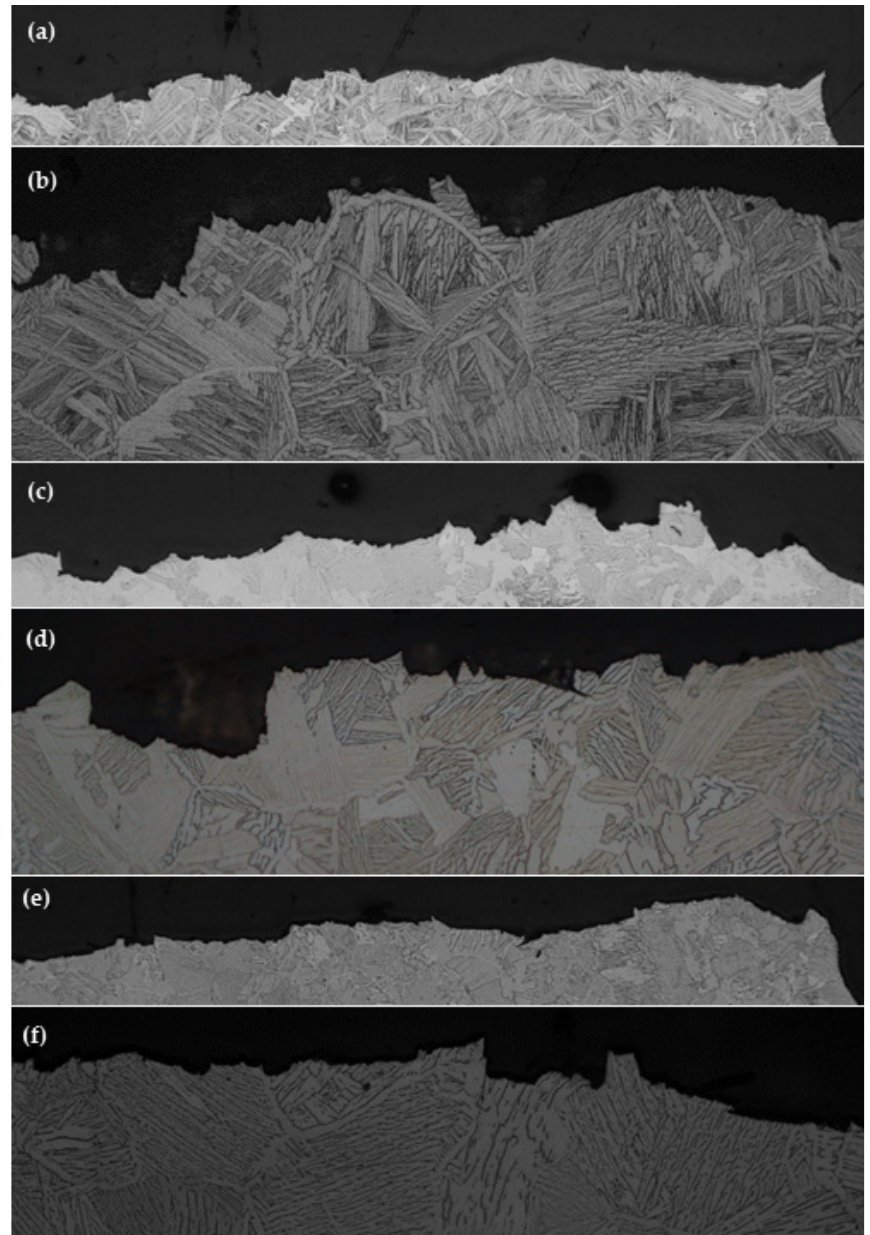
Figure 10. Crack propagation behaviour of impacted specimens ( a , b ) as-extruded ( c , d ) HT-A ( e , f ) HT-B, here images ( a , c , e ) shows a general appearance and ( b , d , f ) illustrates the behaviour of the crack within individual grains.